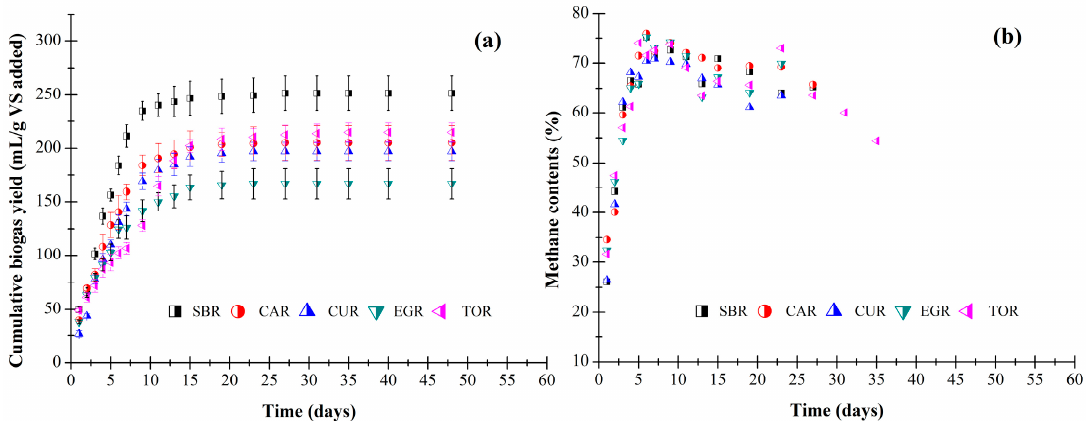
Figure 2. ( a ) Cumulative biogas yield; ( b ) methane contents for biogas produced from different VCRs. The values are means ± standard deviations (vertical bars, n = 3).